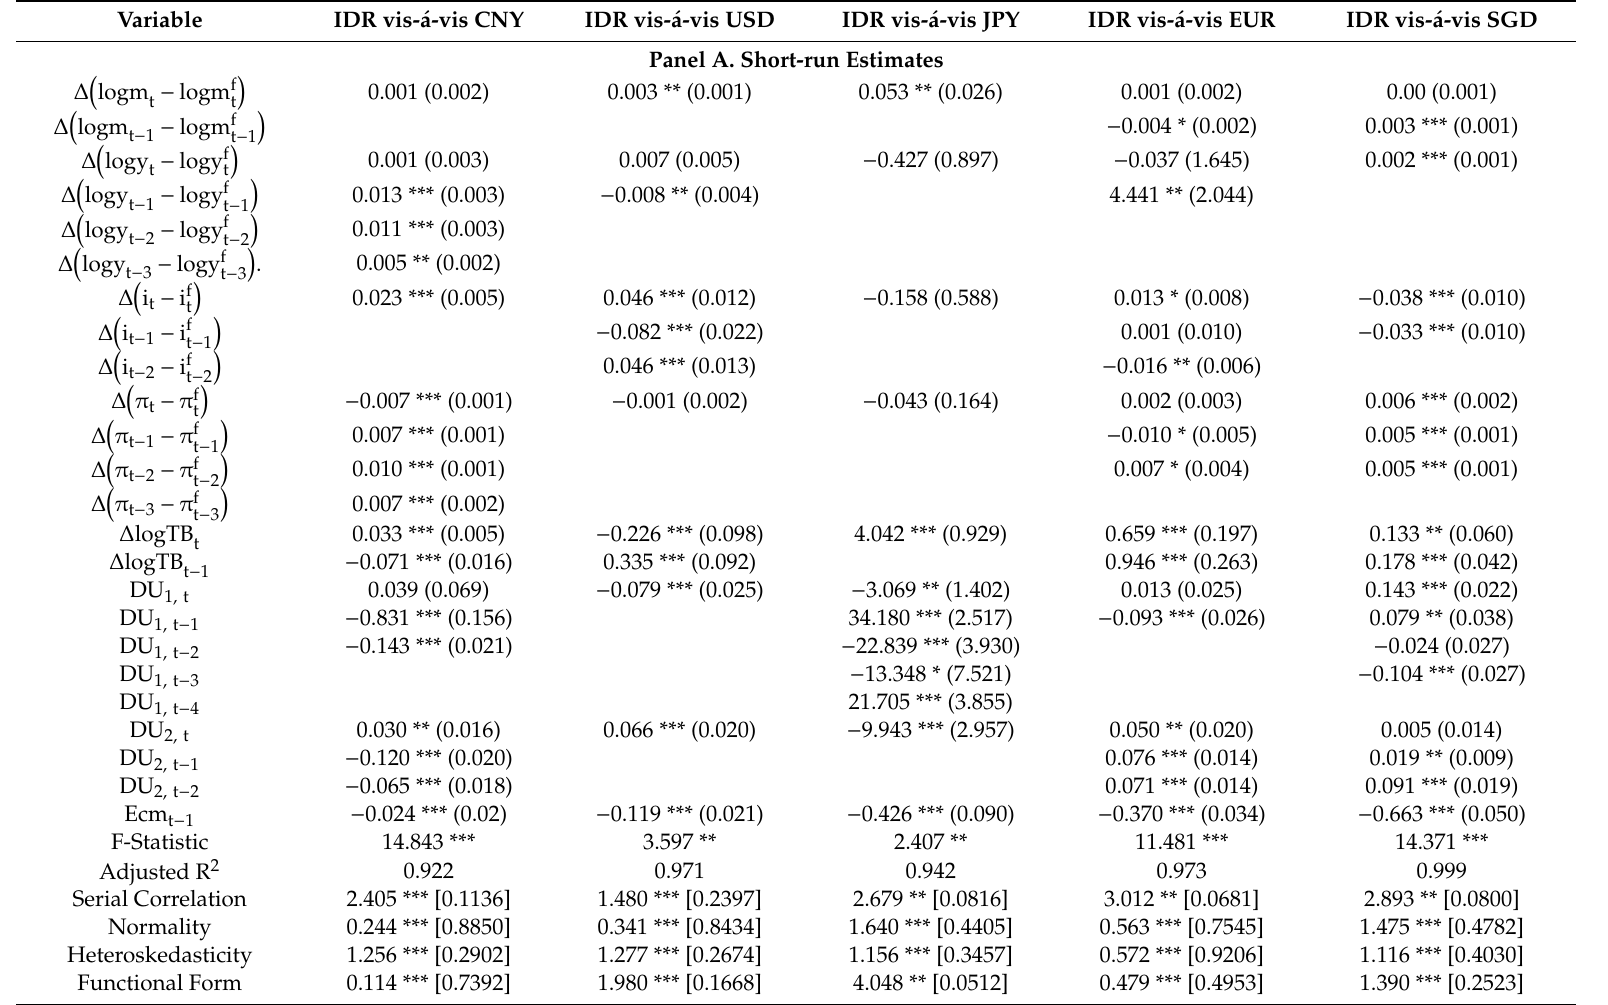
Table 2. Result of Bounds Testing Approach under the Linear ARDL